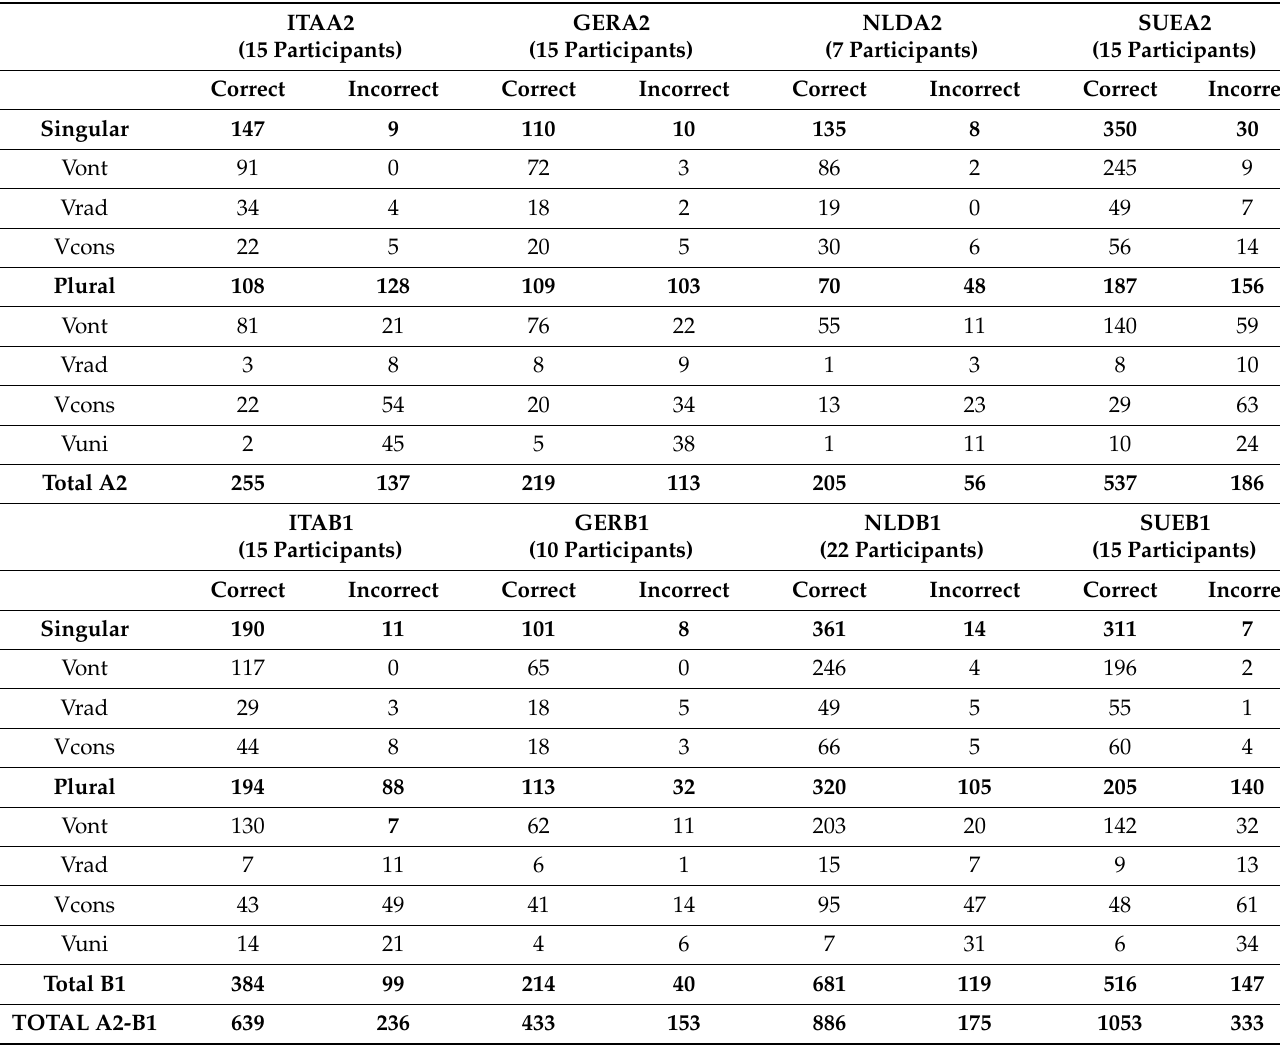
Table A1. Number of Verb Forms that Agree Correctly in Number with Their Subjects, per Context, Proficiency Level and Verb Pattern.